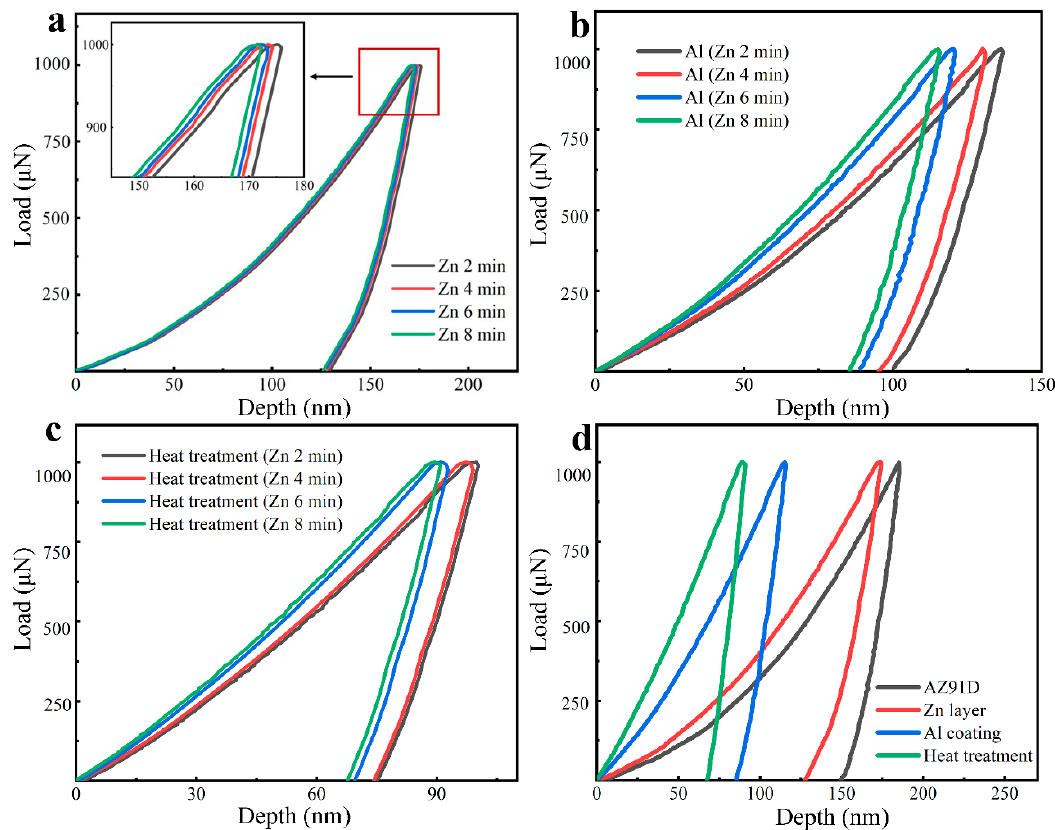
Figure 9. Load–displacement curves obtained from the nanoindentation tests on ( a ) Zn layers (insert is the larger drawing of the rectangular framed region), ( b ) Al coatings, ( c ) Al coatings after heat treatment, and ( d ) the comparison of the load–displacement curves of the AZ91D substrate, the Zn-immersed, the Al-coated, and the heat-treated samples. Table 3. The nanomechanical properties of the AZ91D substrate, the Zn film, the Al coating, β -phase (Mg 17 Al 12 ) and γ -phase (Mg 2 Al 3